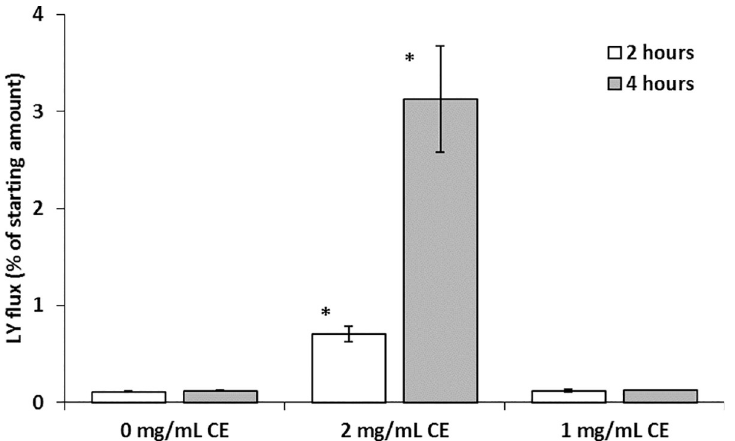
Fig 4. Effect of A . simplex CE on the paracellular permeability in Caco-2 cell monolayers. Caco-2 cell monolayers were exposed to 2 and 1 mg/mL CE. Lucifer yellow was added to the apical compartment and fluorescence in basolateral side was measured after 2 and 4 hours of incubation. The results are expressed as median ± SD and the asterisk indicates significant differences between 0mg/mL and 2 mg/mL for 2 hours (P < 0.001, 95%CI = -0.65—-0.54) and 4 hours (P < 0.001, 95%CI =